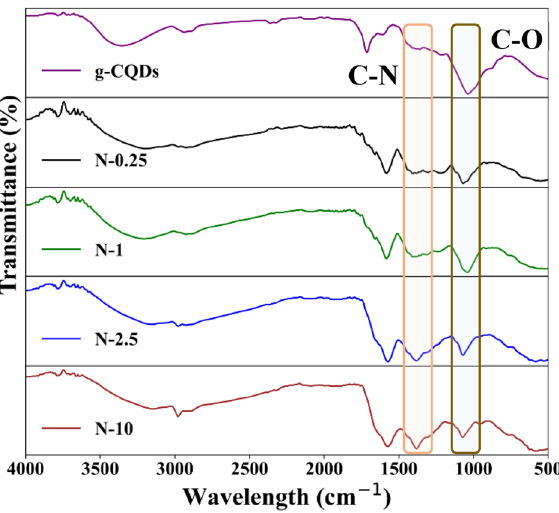
Figure 2. FTIR spectra of N-CQDs with a lower concentration of ammonia (from N-0.25) and higher concentration of ammonia